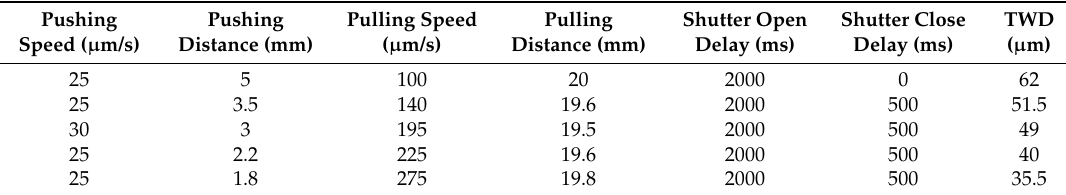
Figure 3. ( a ) Size of hydrogen flame used for long uniform tapering and, ( b ) the cross-section of the fabricated converging/diverging micro nozzle. Table 1. The manufacturing process parameters controlled to fabricate the sensors with a range of sensitivities.